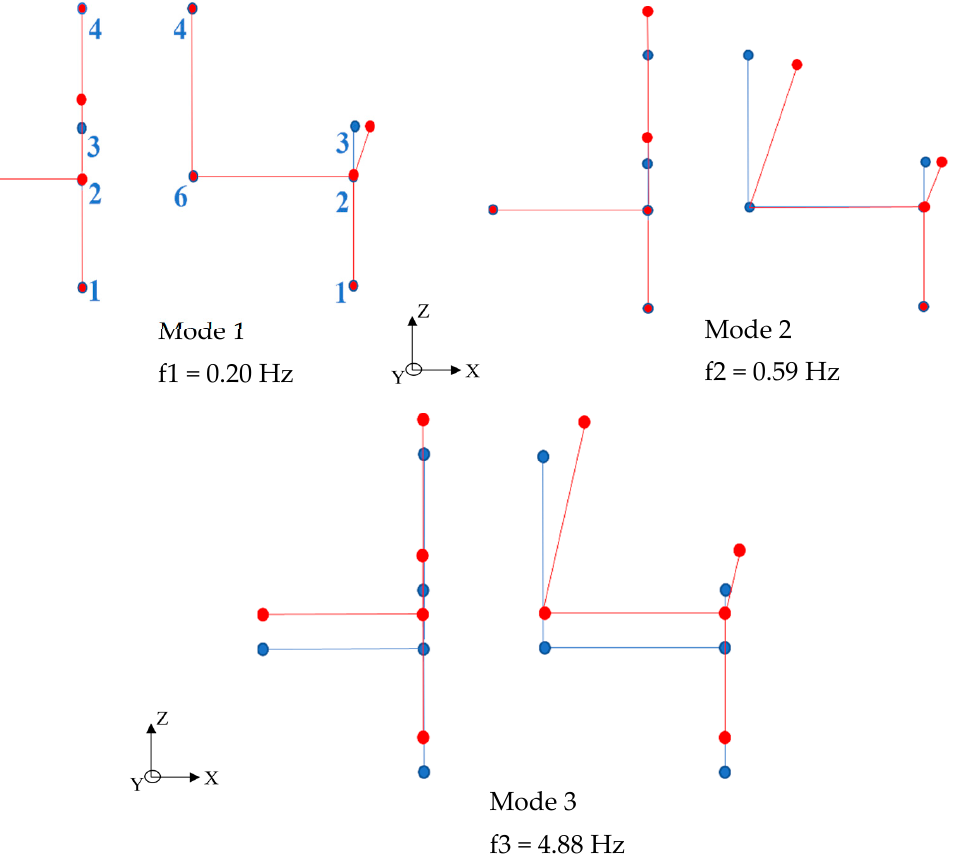
Figure 22. Standard seat experimental modal parameters, where the front and lateral views are presented regarding Intercity trains.